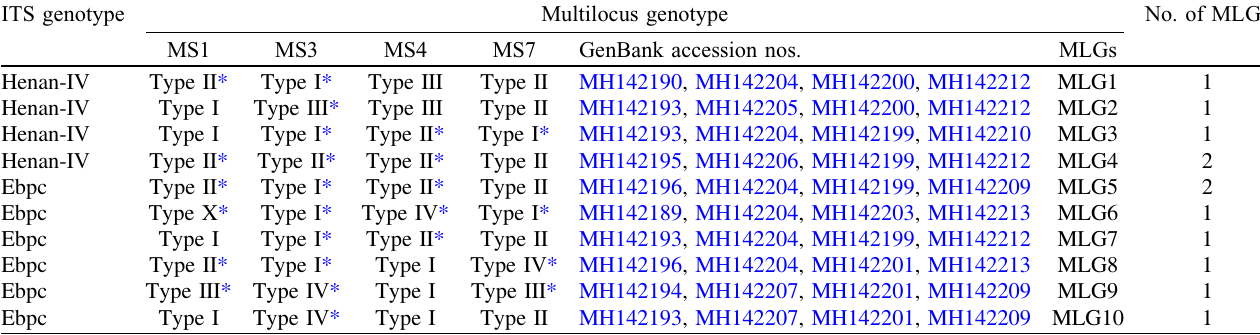
Table 3. Multilocus characterization of Enterocytozoon bieneusi isolates in Tibetan pigs in southwestern China. ITS